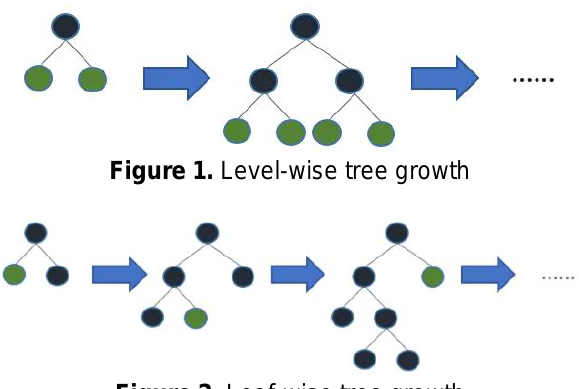
Algorithm 1. Gradient-based One-Side Sampling